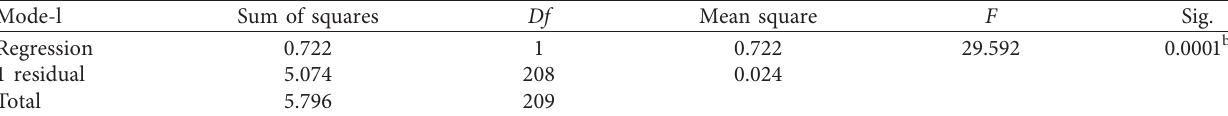
Table 8: ANOVA impact of BIM on scheduling (ANOVA a ).